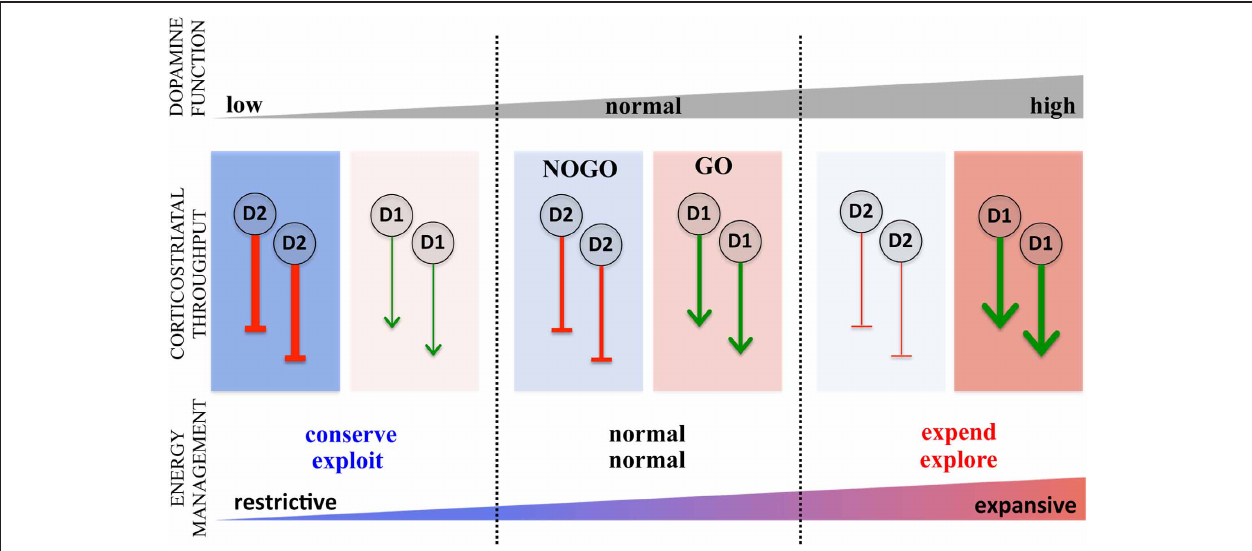
FIGURE 2 | Role of direct and indirect pathway modulation of corticostriatal throughput in regulating the energy expenditure. The striatum modulates cortical processing via corticostriatal-thalamocortical loops through the basal gangia through two pathways, the direct, nigrostriatal (“GO”) and the indirect, striatopallidal (“NOGO”), expressing predominantly D1 and D2 dopamine receptors, respectively. Acting on D1 in the GO pathway (red toned boxes), dopamine disinhibits corticostriatal throughput facilitating activity while dopamine activation of D2 inhibits the NOGO pathway (blue toned boxes), also facilitating activity by dampening the inhibitory influence of the indirect. Conversely, decreases in dopamine diminish D1 mediated disinhibition of the GO pathway and D2 mediated inhibition of the NOGO pathway, both